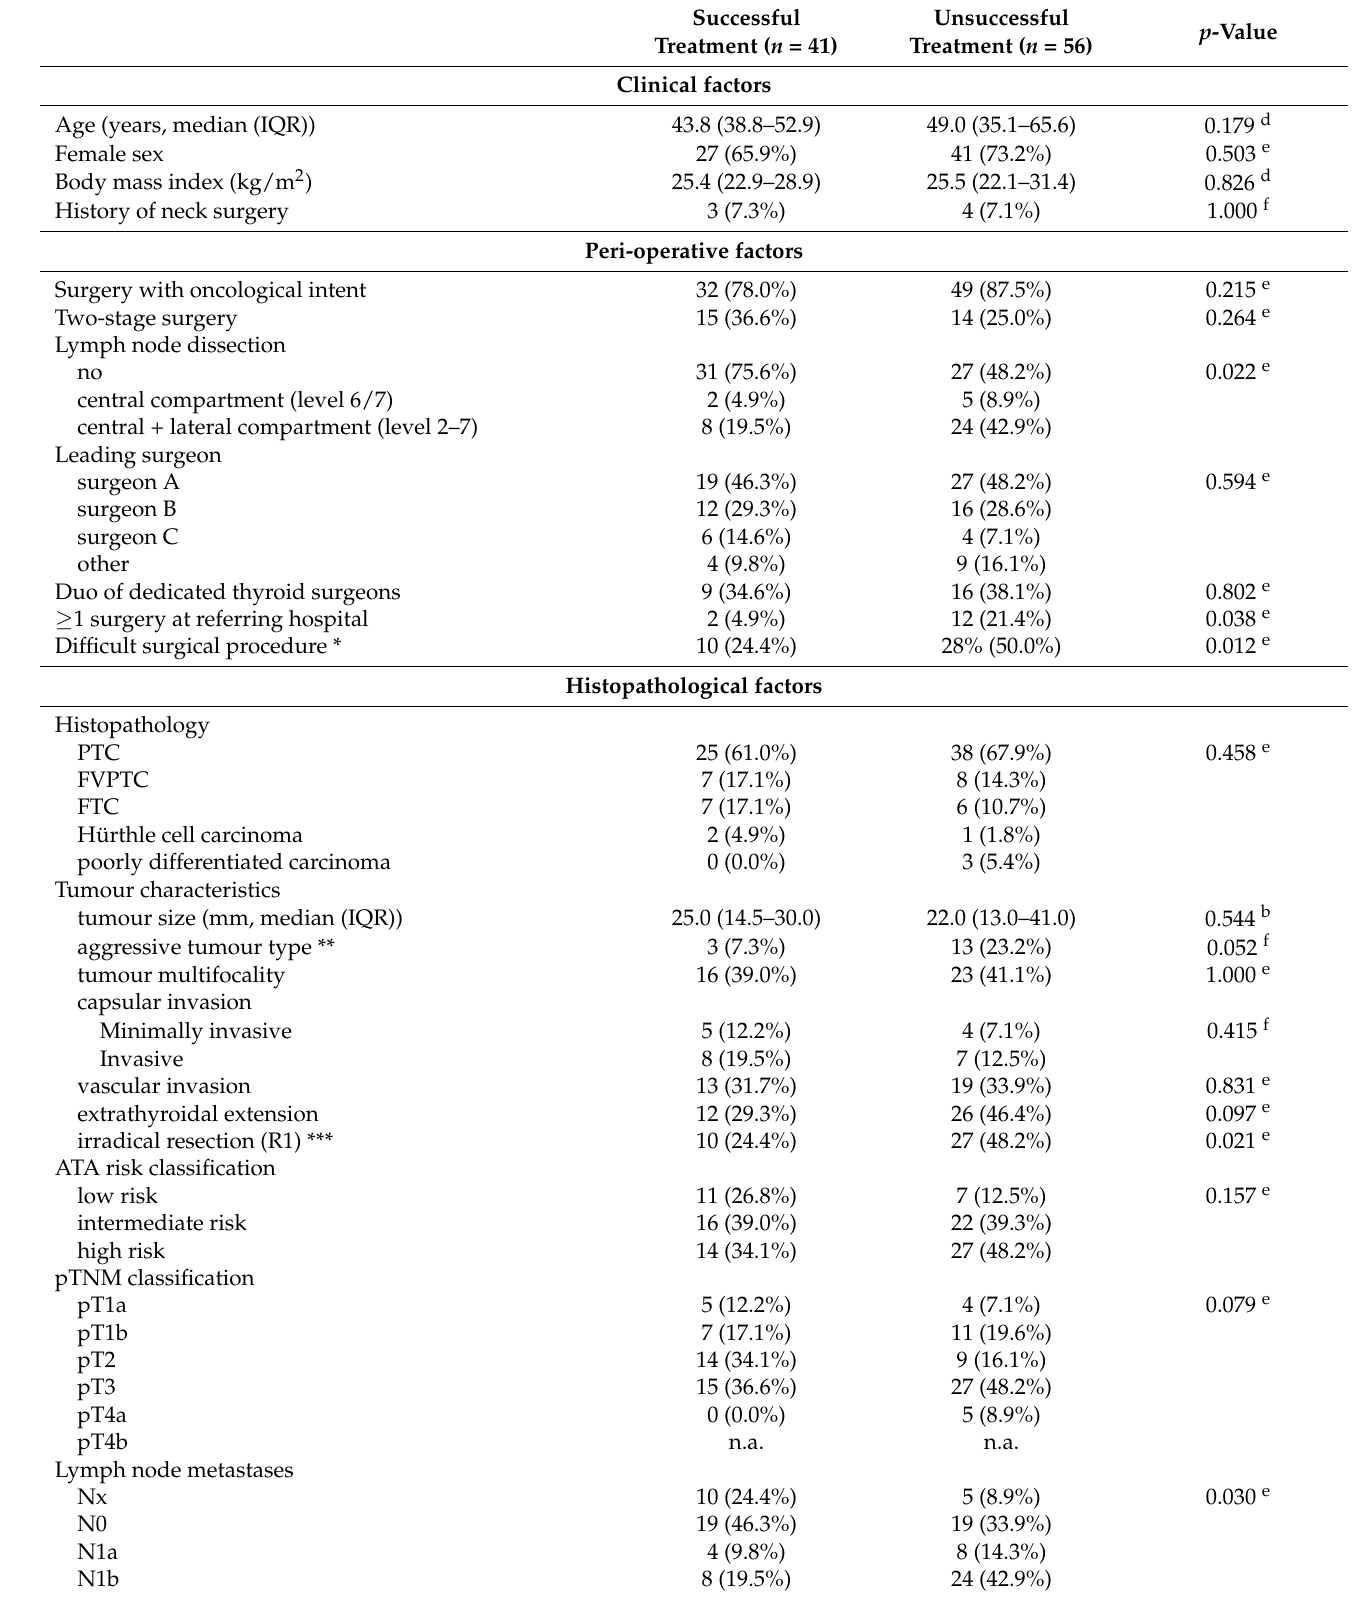
Table 3. Factors associated with treatment success ( n =